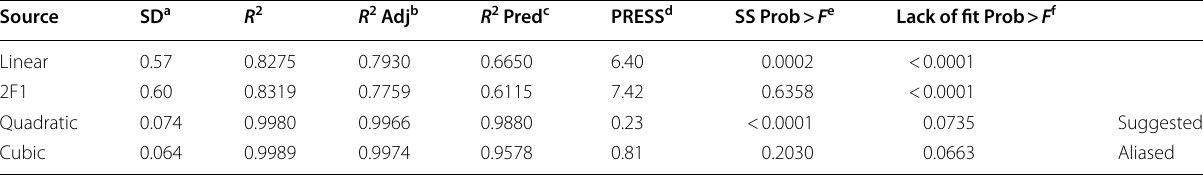
Table 9 Suggested model summary statistics (model II)